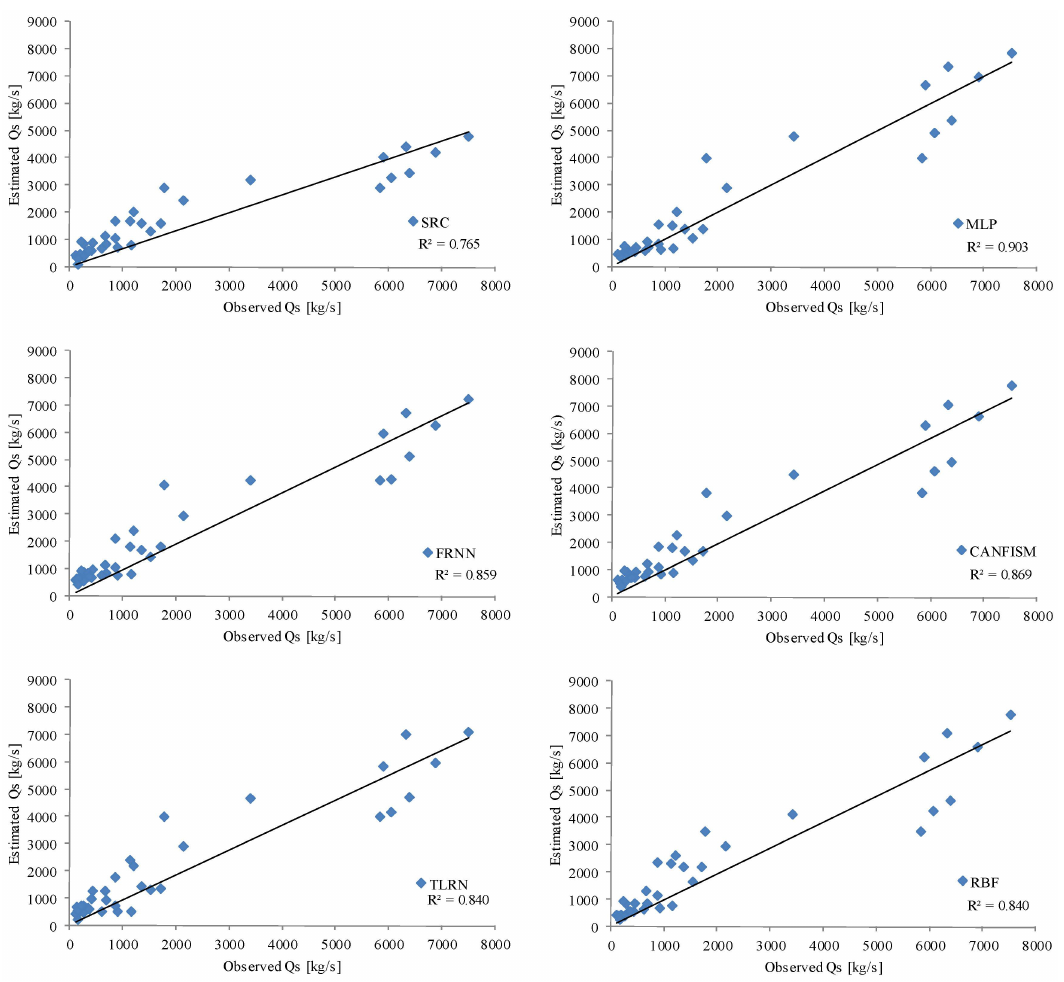
Figure 12. Scatter plots of observed and estimated discharge using the five ANNs compared to